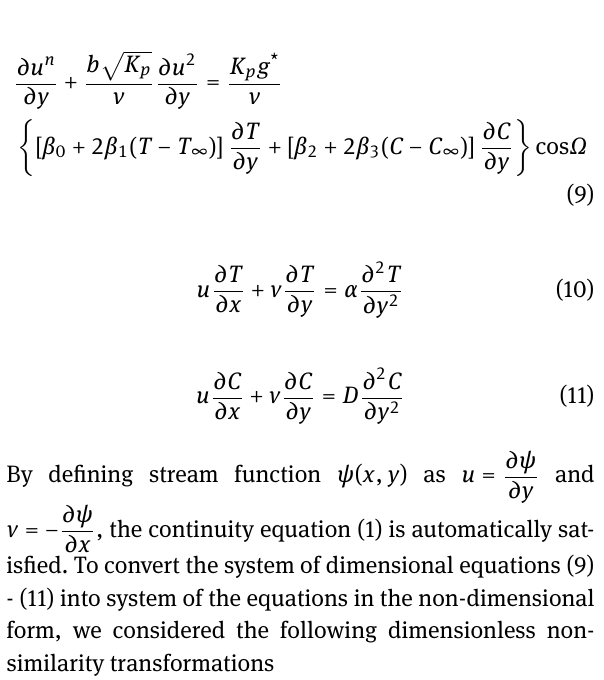
Fig. 1: Schematic diagram of the